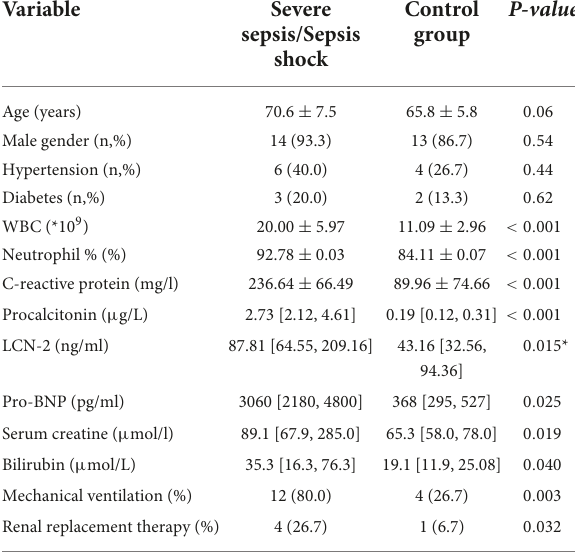
TABLE 1 Baseline characteristics of the